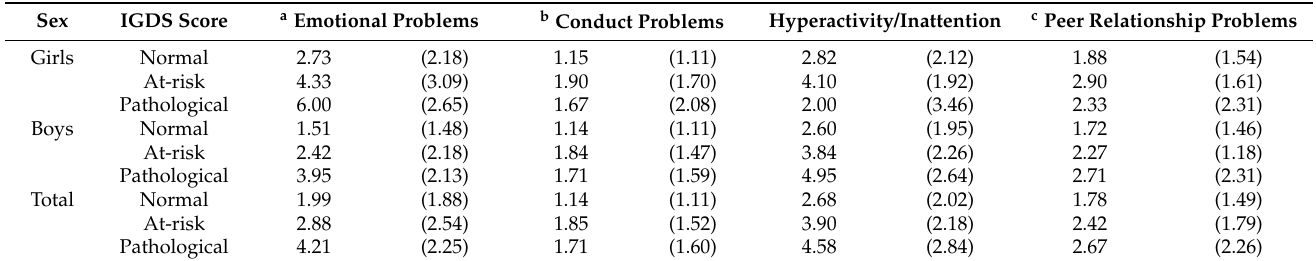
Table A5 in the Appendix A shows the distribution of emotional and behavioral problems (assessed by SDQ) depending on the IGDS categories. Approximately one-third of at-risk boys simultaneously reported borderline or clinically severe emotional problems and hyperactivity/inattention. The same is true for two fifths of the girls classified as at-risk according to the German standards of Becker et al. [33]. The results of Table A5 in the Appendix A should be considered with the caveat of small sample